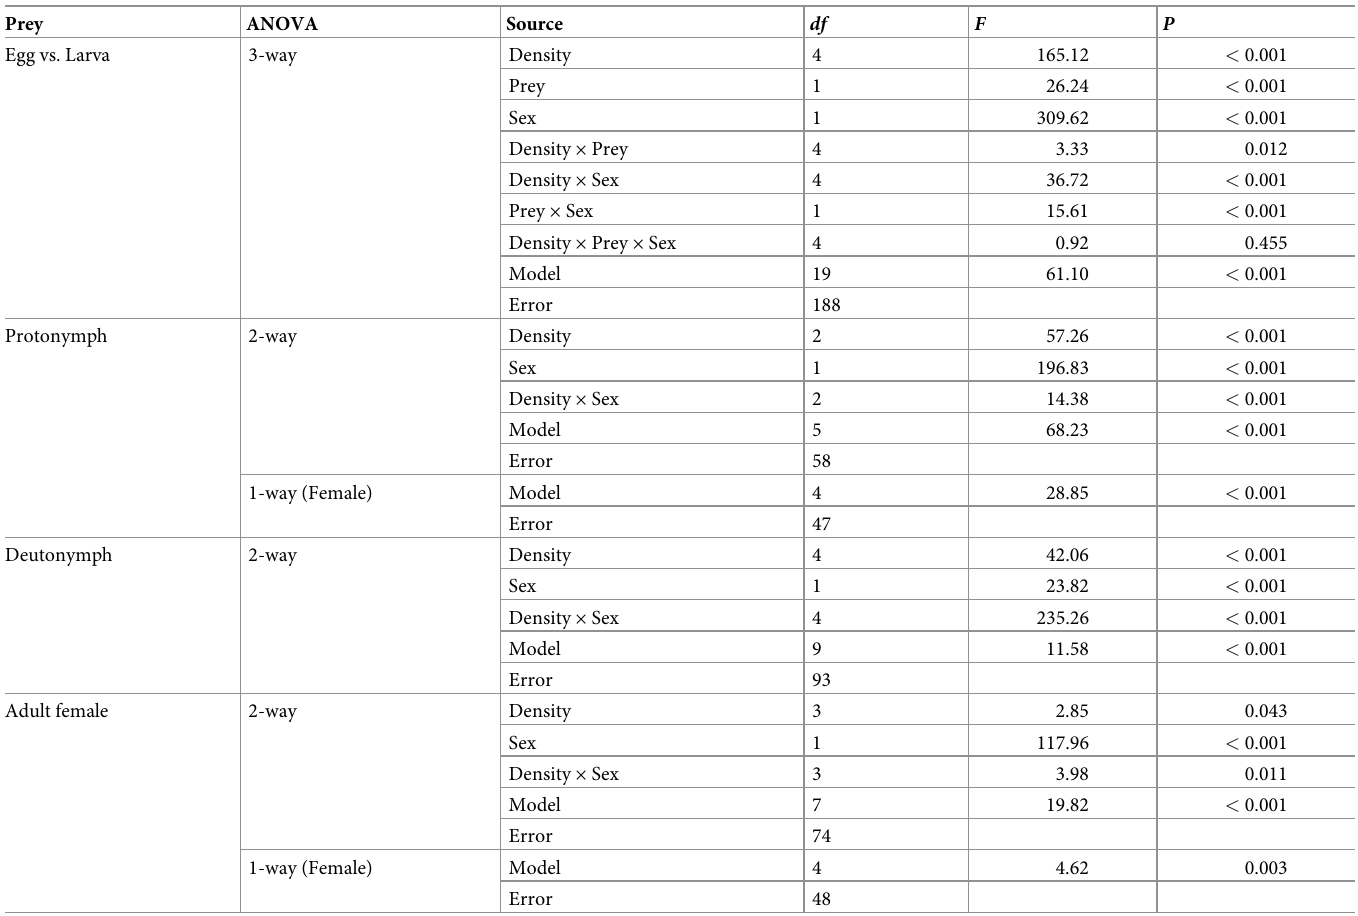
Table 2. ANOVA results of predation rate of Amblyseius eharai on different stages of Tetranychus urticae . Prey Egg vs. Larva